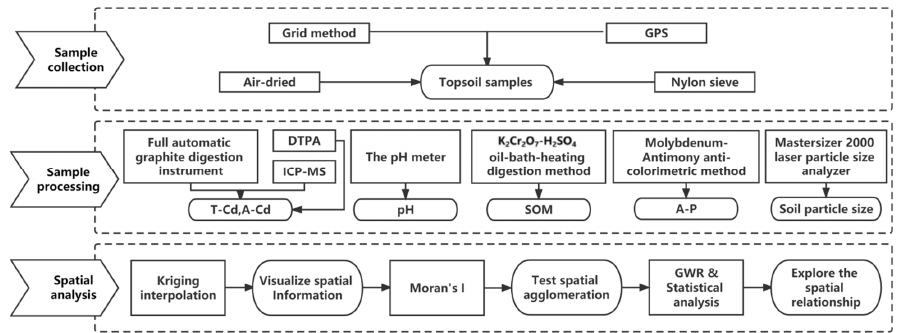
Figure 2. Technical flow